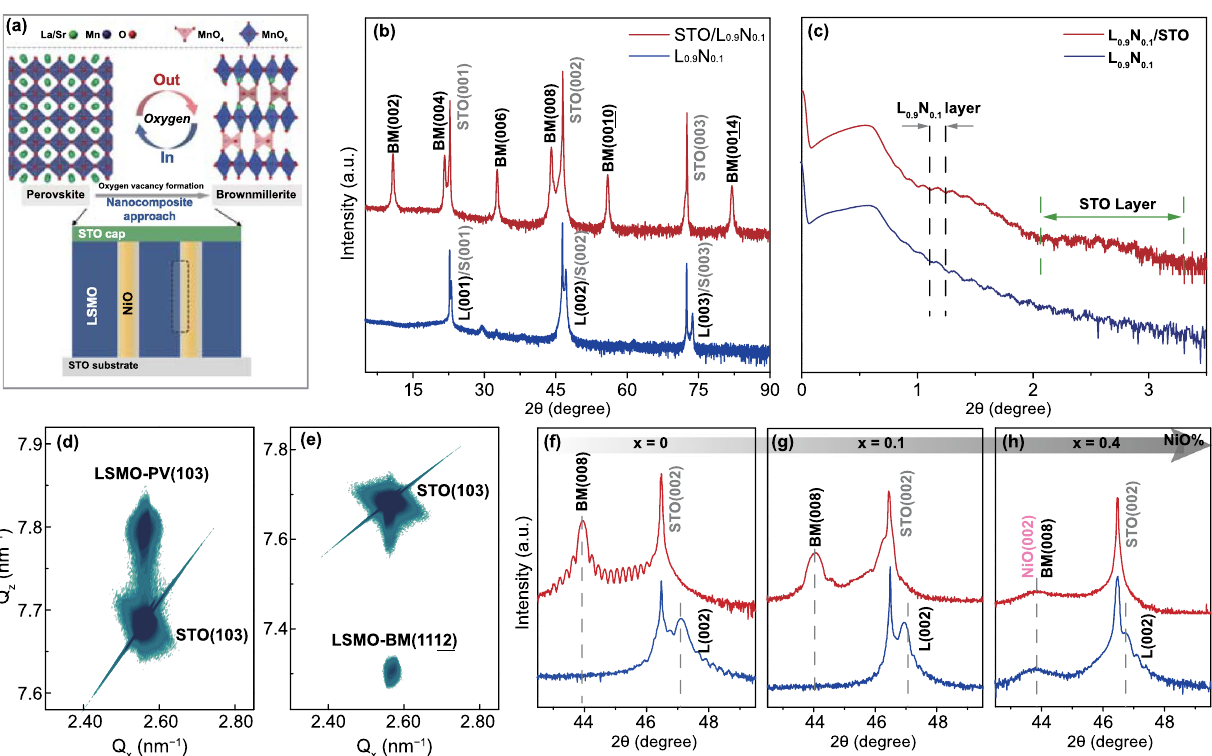
Fig. 1 a Process schematic of the thin-film structure consisting of the vertically oriented NiO nanopillars and STO cap layer with a crystal- lographic model illustrating the PV-to-BM topotactic phase transformation assisted by oxygen stoichiometry engineering. b θ − 2 θ XRD scans and c XRR scans of an as-grown L 0.9 N 0.1 film and a vacuum-annealed STO/L 0.9 N 0.1 film. RSM scans near the asymmetric STO (103) diffrac- tion peak for d an as-grown L 0.9 N 0.1 films and e a vacuum-annealed STO/L 0.9 N 0.1 films. The LSMO peak is given in the orthorhombic notation. θ − 2 θ XRD local scans of an as-grown PV (blue) films and a vacuum-annealed STO/L x = 0, g x = 0.1, h x = 0.4. The film 1- x N x film (red) with f peaks are marked with dashed